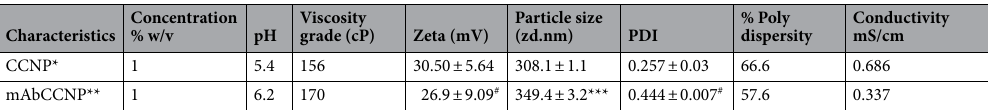
Concentration % w/v pH